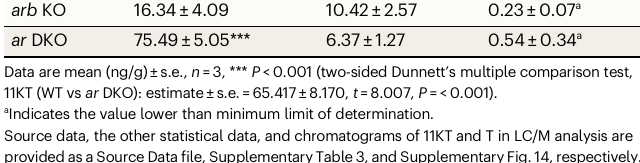
(Table 1). Expression analysis of gonad-speci fi c genes, vasa , P450c17 and gsdf , indicates that germ cells, Leydig cells, and Sertoli cells were formed in the testes of ar DKO as in ar single KOs (Supplemen- tary Fig. 4).